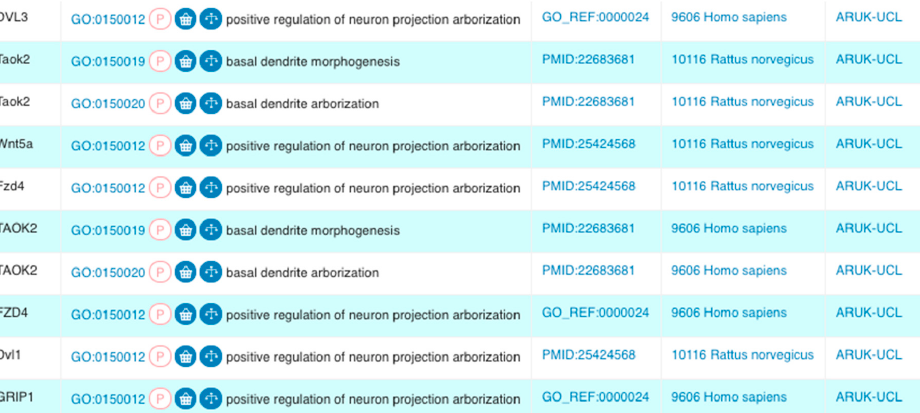
Figure 1. A selection of Gene Ontology (GO) annotations created by Alzheimer’s Research United Kingdom (ARUK)—University College London (UCL), as a part of our project that focused on capturing knowledge on amyloid-beta and tau by the expert biocuration of experimental data available through the biomedical literature. These annotations describe related biological processes using GO terms, which are descendants of the ‘neuron projection development’ GO term. We created 13 and revised two of the 24 GO terms in this branch. We created a total of 50 new annotations using these new neurological GO terms (Results sections: Revisions and development of neuron projection GO branches; Figure 4). ‘Symbol’ corresponds to the HUGO Gene Nomenclature Committee (HGNC)-approved gene symbol [20] encoding the gene product being annotated; the ‘GO Term’ section provides the GO identifier and term name; the ‘Reference’ column lists the source of the data supporting the annotation; this may be the curated article or information about the electronic annotation pipeline. The ‘Taxon’ column describes the species of origin of the protein being annotated; and the ‘Assigned By’ column shows that these annotations resulted from this project (Screenshot from QuickGO—accessed: 31 October 2018).